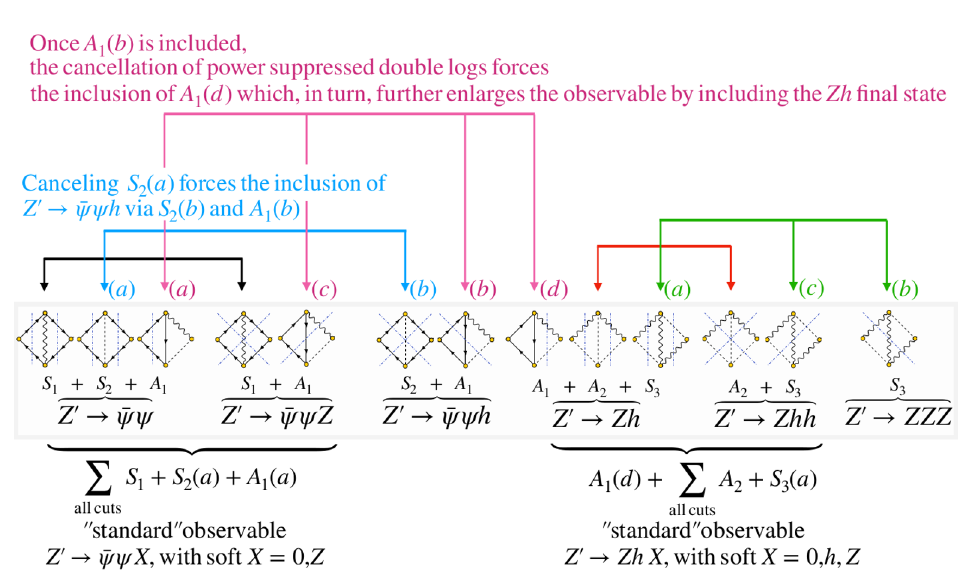
Figure 4 . Schematic of the relations between various two- and three-body decay channels describing, respectively, virtual and real corrections in the context of the model discussed in section 4. The colored arrows on the top indicate diagrams that are connected by the IR unitarity theorem (see also figure